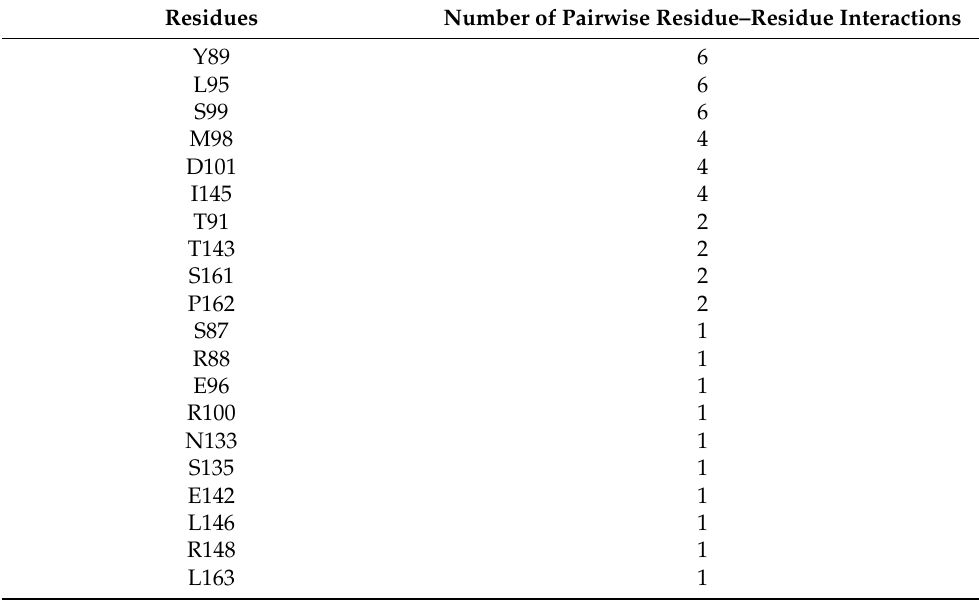
Table 6. NS1 residues participating in the most stable NS1-PI3K interfacial pairwise interactions.